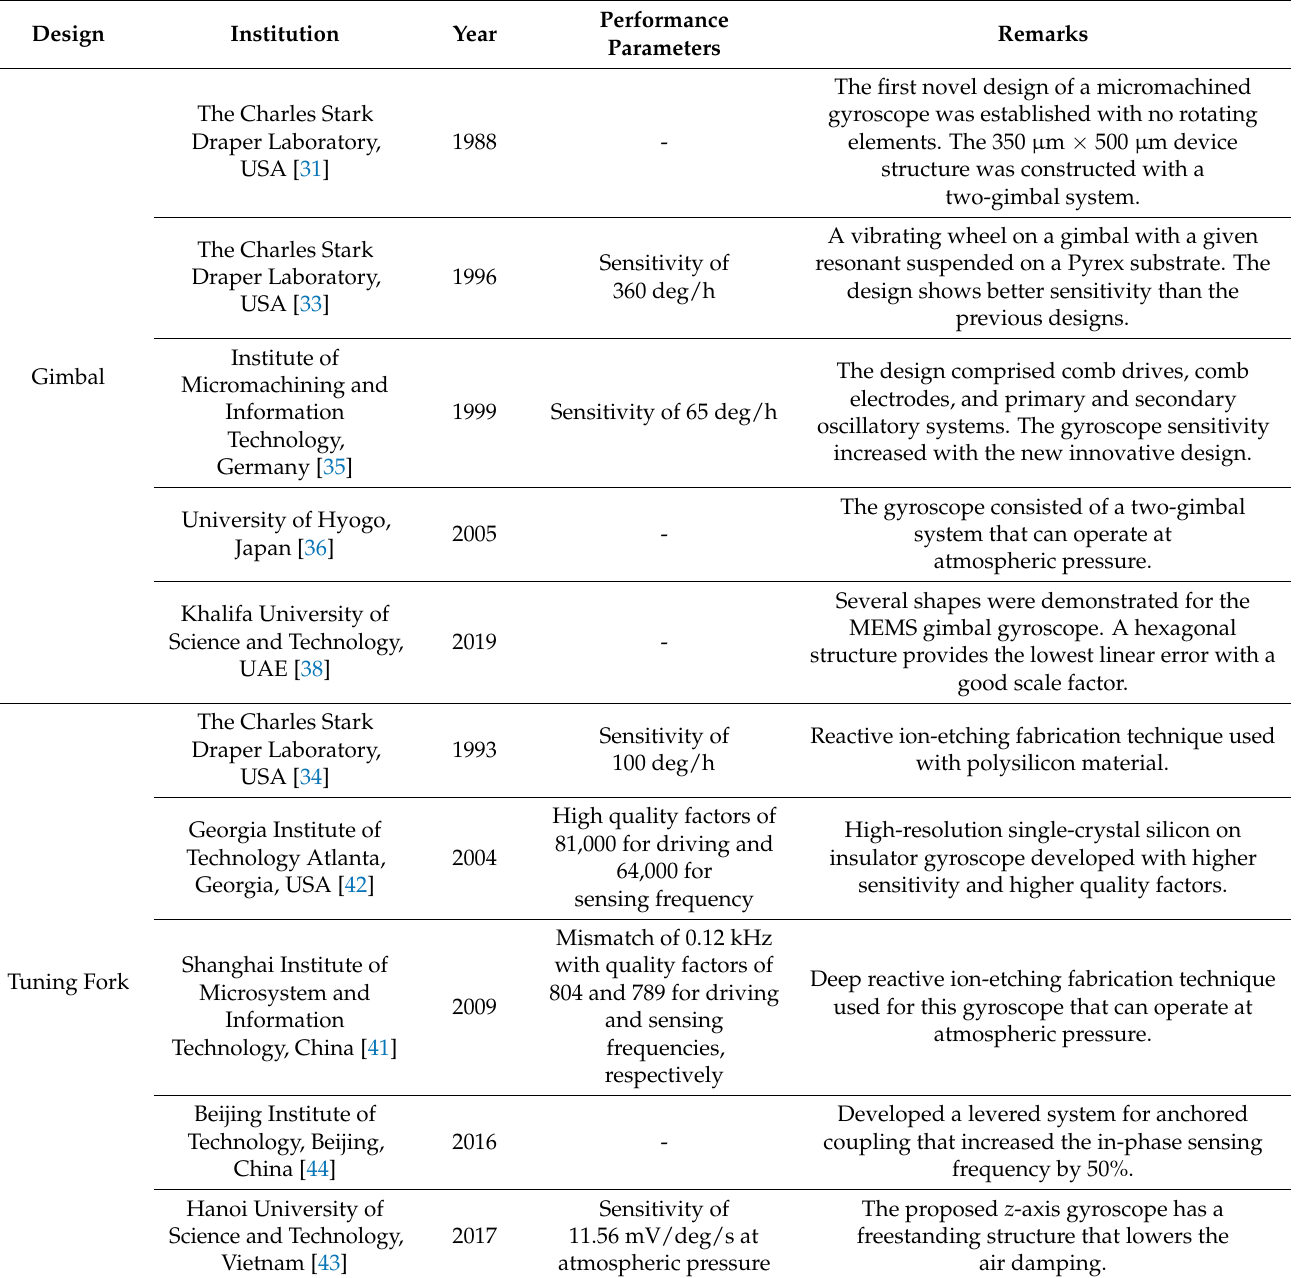
Table 1. Summary of the development of the most common MEMS vibrating